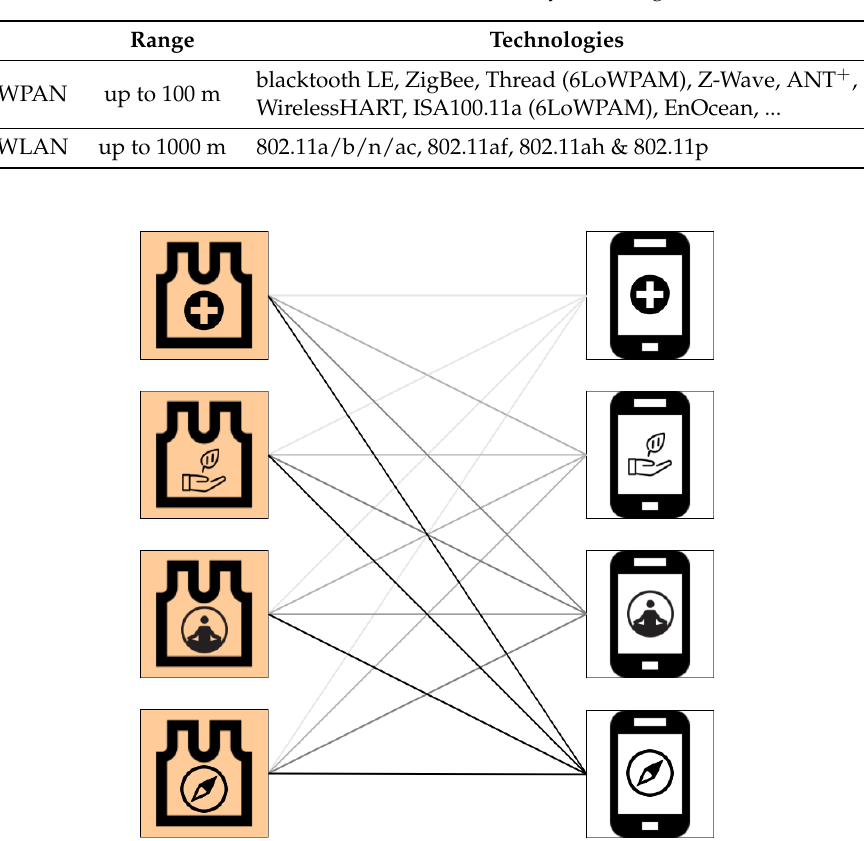
Figure 5. Field research cooperative wearable system